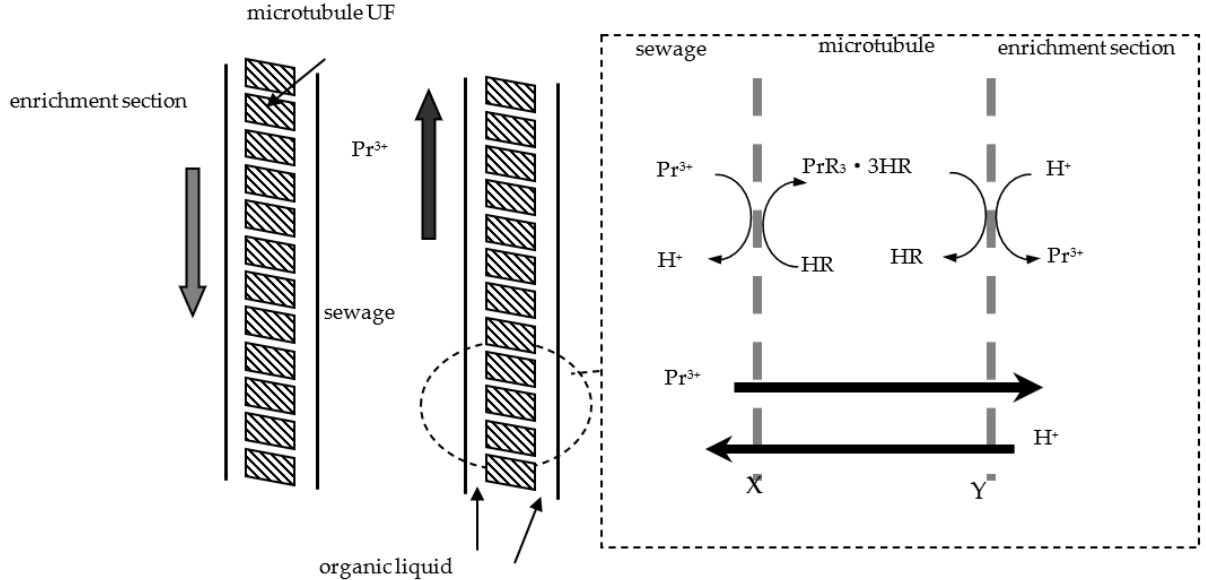
Figure 2. Schematic principle and description of Pr 3+ migration MUFR. (a) Praseodymium(III) diffuses from the sewage section to interface